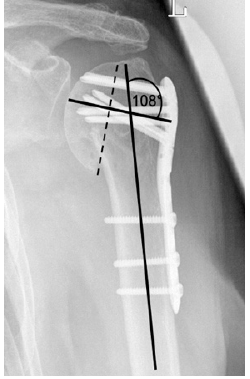
Figure 14. Complication Type 2c. Measurement of varus displacement on an a.p. radiograph of a left shoulder after angular stable plate osteosynthesis with same-sided complication. The cranial screws penetrate the cortical bone. Varus displacement is 27° relative to the anatomic CCD angle of 135°.